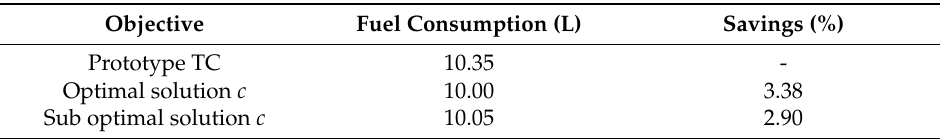
Table 2. Comparison results for total fuel consumption.